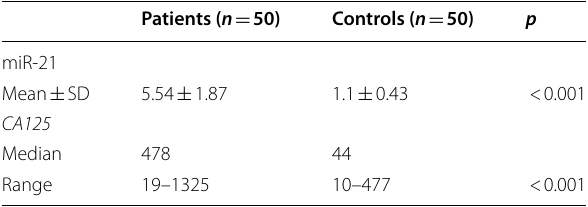
Table 3 Comparison of serum miR-21 expression and CA-125 serum levels among patients and controls